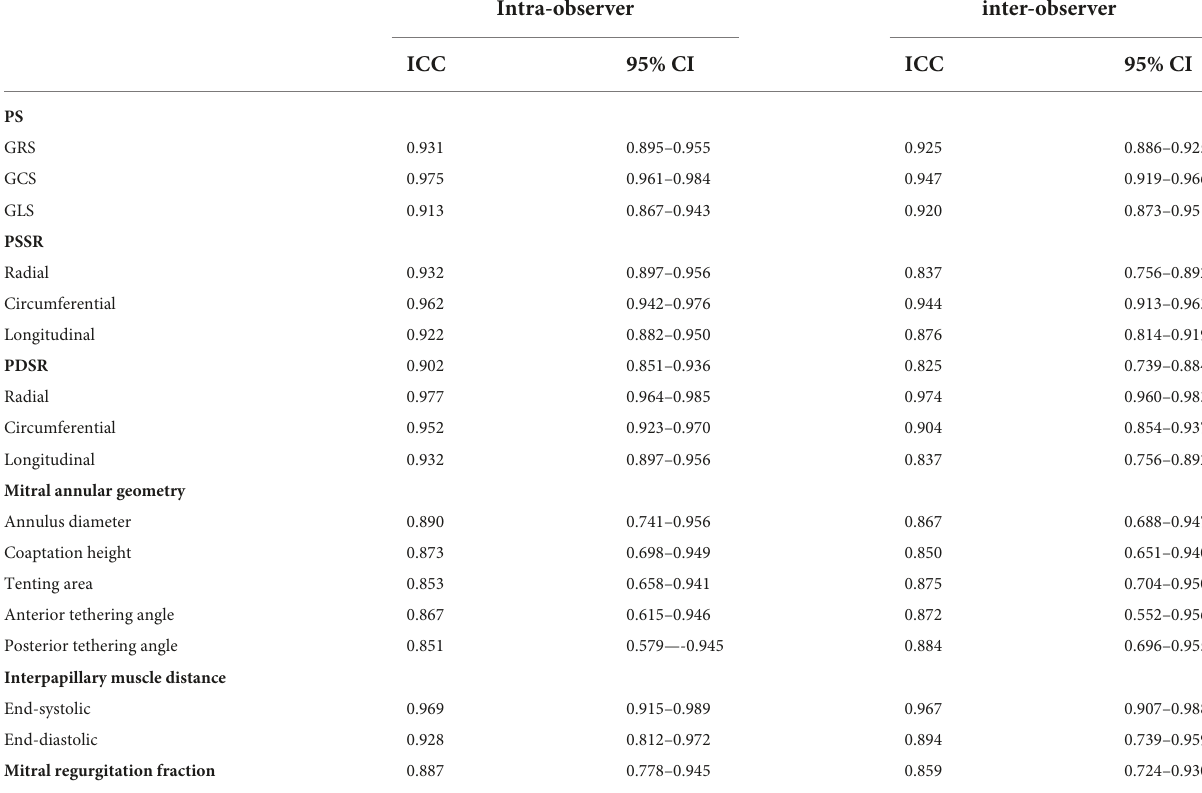
TABLE 6 Intra-and inter-observer variabilities of LV strain, mitral annular geometry and mitral regurgitation